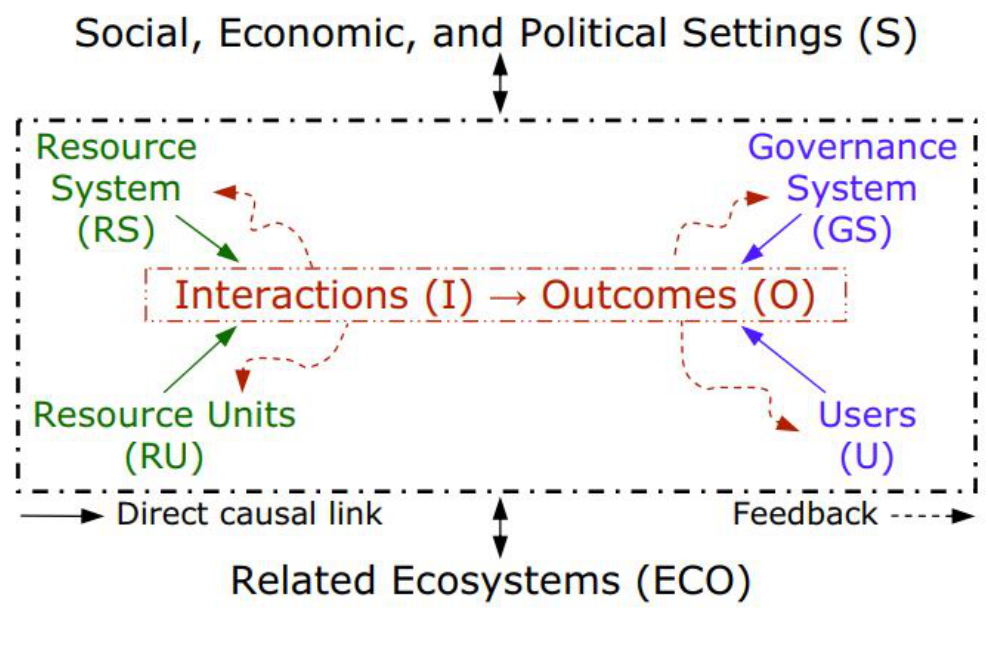
(Source: Ostrom 2007:15182)